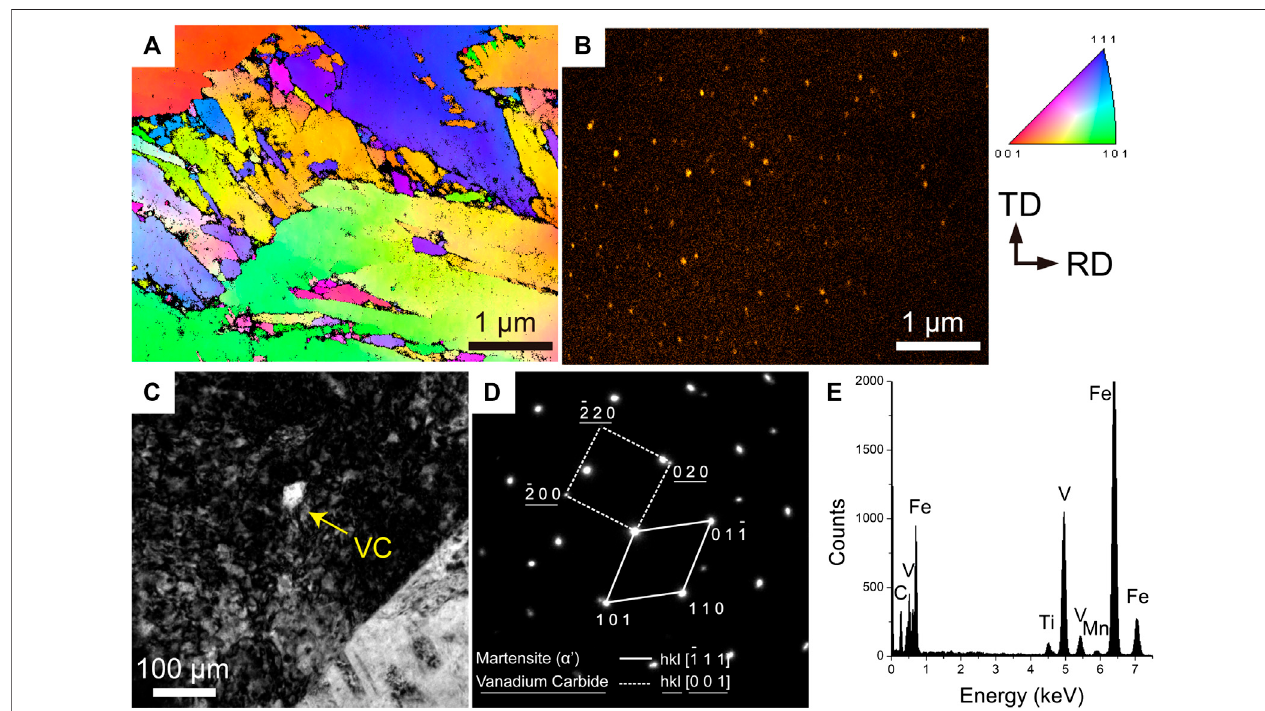
FIGURE 4 | (A) TKD IPF-ND showing martensite microstructure and (B) EDS mapping showing the distribution of vanadium; (C) TEM bright- fi eld micrograph showing VC particle and (D) the corresponding diffraction pattern and (E) EDS analysis.